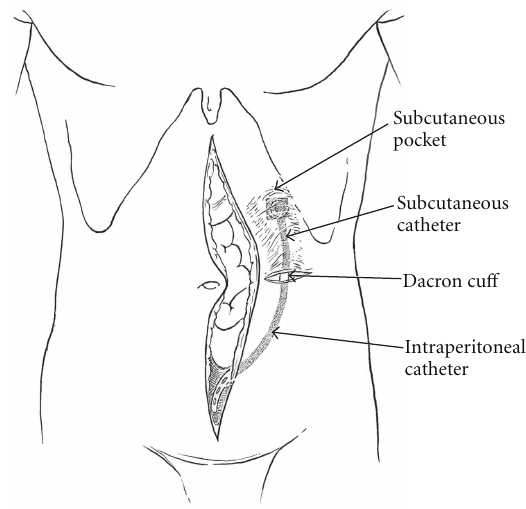
Figure 1: A lateral skin incision allows dissection of the port pocket and access to the abdomen using a stab